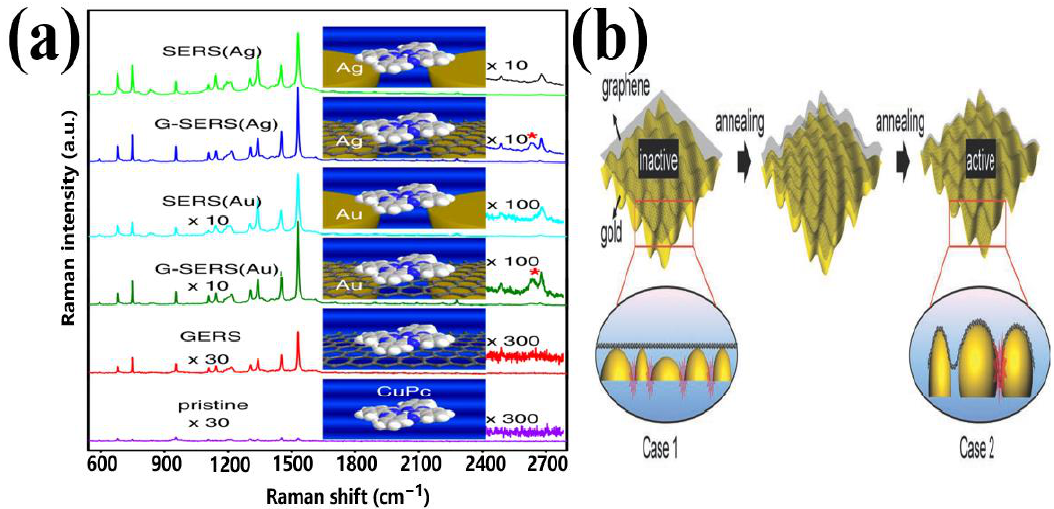
Figure 1. ( a ) Comparison of the SERS spectra of CuPc molecules on Ag NPs, graphene-Ag NPs, Au NPs, graphene-Au NPs, graphene and pristine CuPc, respectively. Reprinted from Ref. [7] with permission of 2012 Proceedings of the National Academy of the Sciences. ( b ) Schematic illustration of graphene-veiled SERS substrates with graphene spread over the curved side of Au nano-islands in two cases. Case 1 (SERS-inactivity) and case two (SERS activity) were the cases before and after an activation process of thermal annealing, respectively. Reprinted from Ref. [30] with permission of 2013 Wiley Online Library.